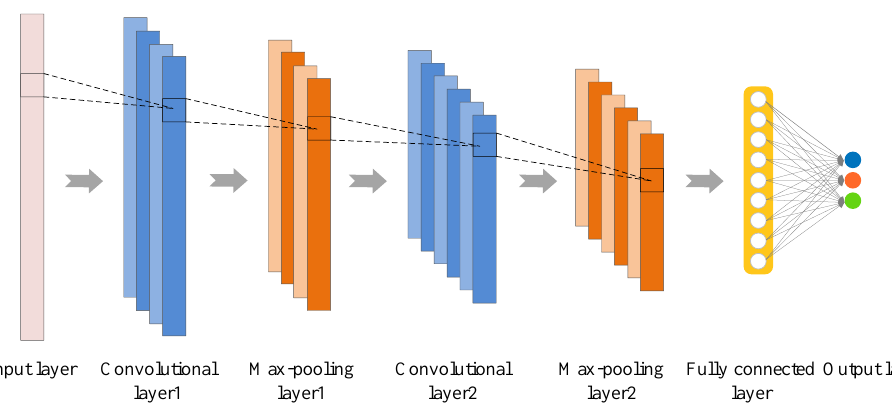
Figure 1. The structure of 1D CNN model.